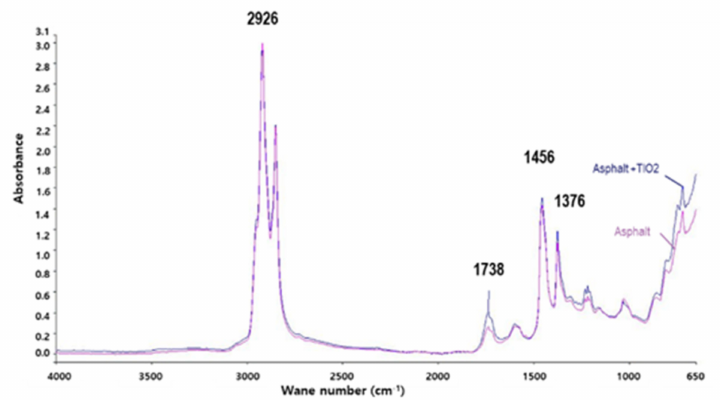
Figure 11. FT-IR spectrum of asphalt and asphalt with TiO 2 .